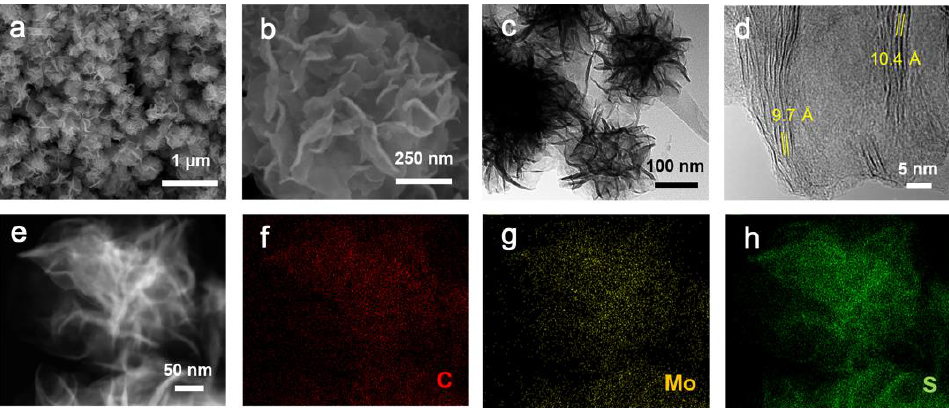
Figure 2. Morphology of samples. ( a , b ) SEM images of C-MoS 2 -1. ( c ) Low-resolution TEM of C-MoS 2